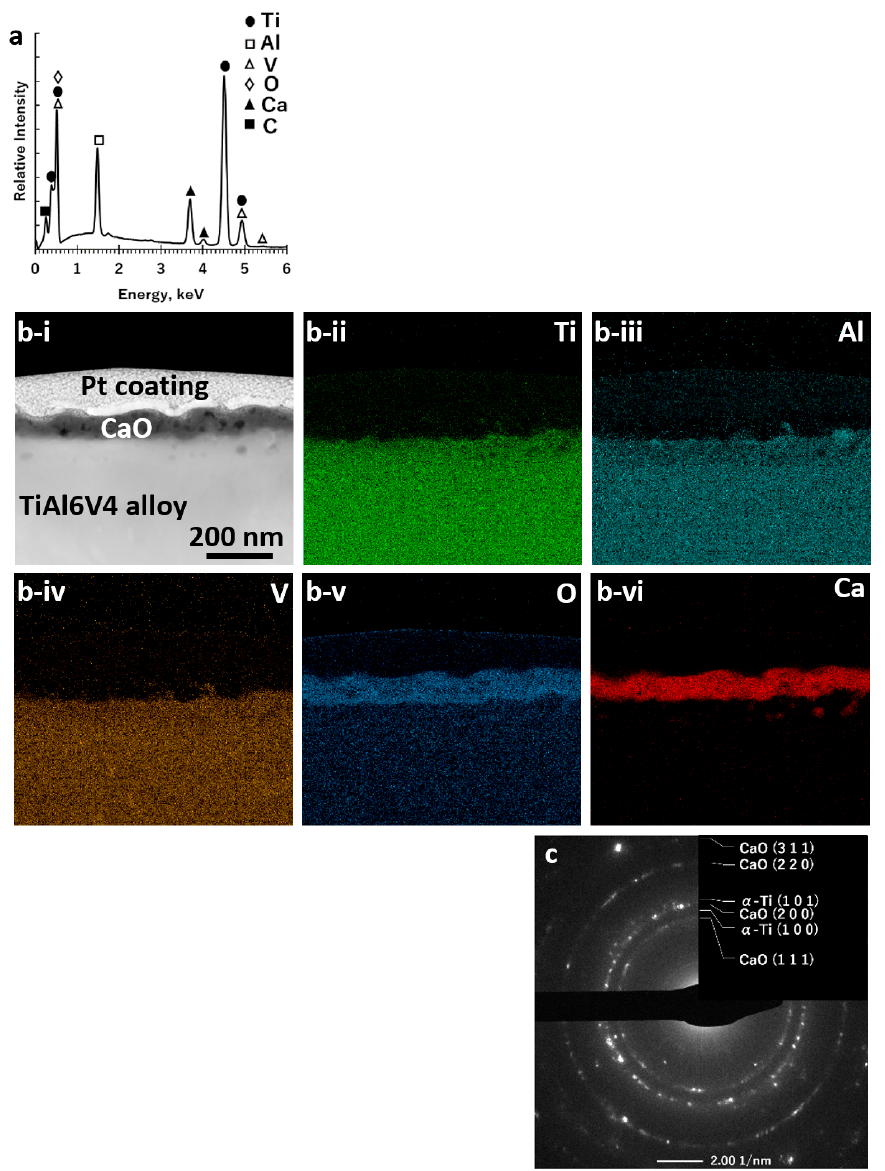
Figure 4. Characterization of a polished, oxidized DMLS TiAl6V4 specimen after calciothermic reaction at 700 °C for 1 h: ( a) SEM/EDX spectrum obtained from top-down analysis of the external surface; ( b-i ) cross-sectional STEM image and associated EDX elemental maps for ( b-ii ) titanium, ( b-iii ) aluminium, ( b-iv ) vanadium, ( b-v ) oxygen, and ( b-vi ) calcium obtained from an ion-milled cross-section at the surface; ( c ) SAED pattern, consistent with the presence of CaO and an α -Ti-rich phase, obtained from an ion-milled cross-section at the